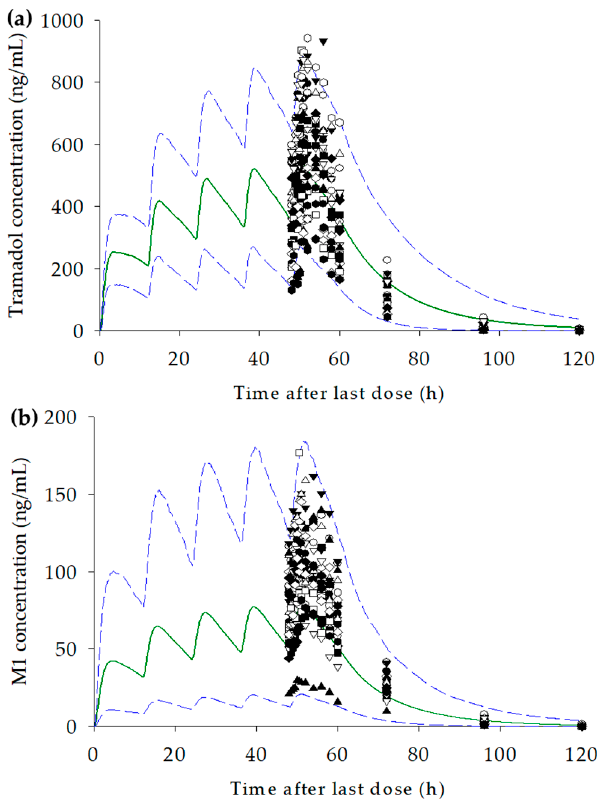
Figure 3. The observed (each symbol, n = 23) and simulated mean (solid dark green line) plasma concentration–time profiles after administration of 100 mg tramadol extended-release (ER) tablet twice daily (total five times) for ( a ) tramadol, and ( b ) O -desmethyltramadol (M1); blue dashed line represents 5 th and 95 th percentiles. Table 4. Observed and simulated pharmacokinetic (PK) parameters for tramadol and O -desmethyltramadol (M1) after oral administration of 100 mg tramadol ER tablet twice daily (five times in total).